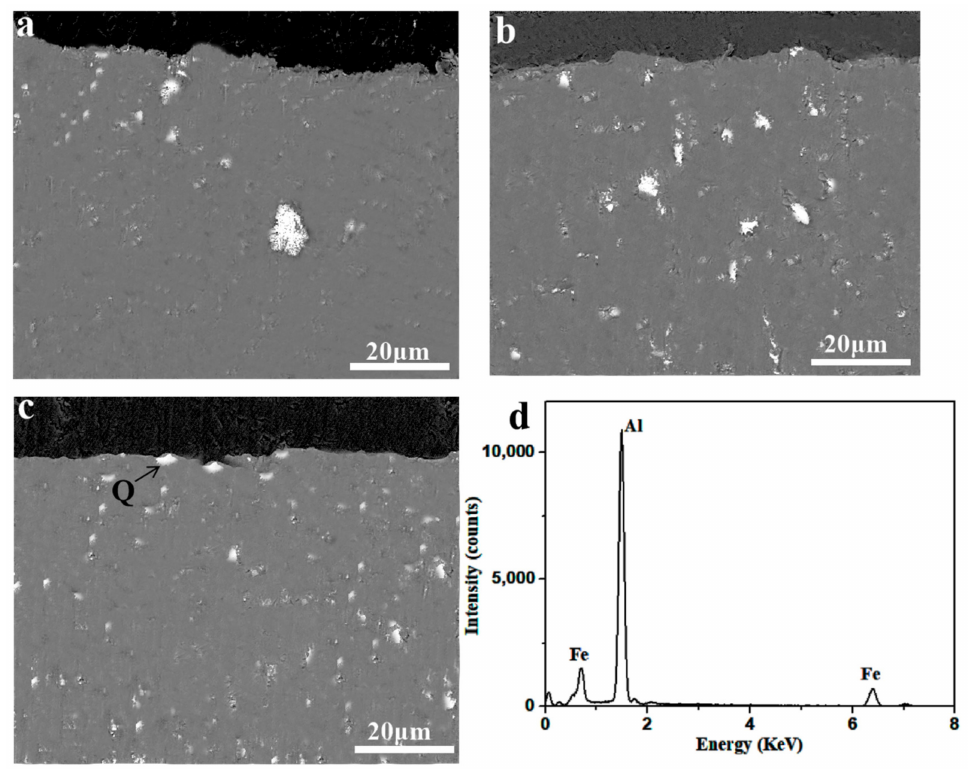
Figure 7. Corrosion cross sections of the Al–xFe–0.1Si–0.07La alloy foils tested in a 3.5% NaCl solution: ( a ) Al–0.07Fe–0.1Si–0.07La; ( b ) Al–0.2Fe–0.1Si–0.07La; and ( c ) Al–0.4Fe–0.1Si–0.07La. ( d ) EDS analysis of phase